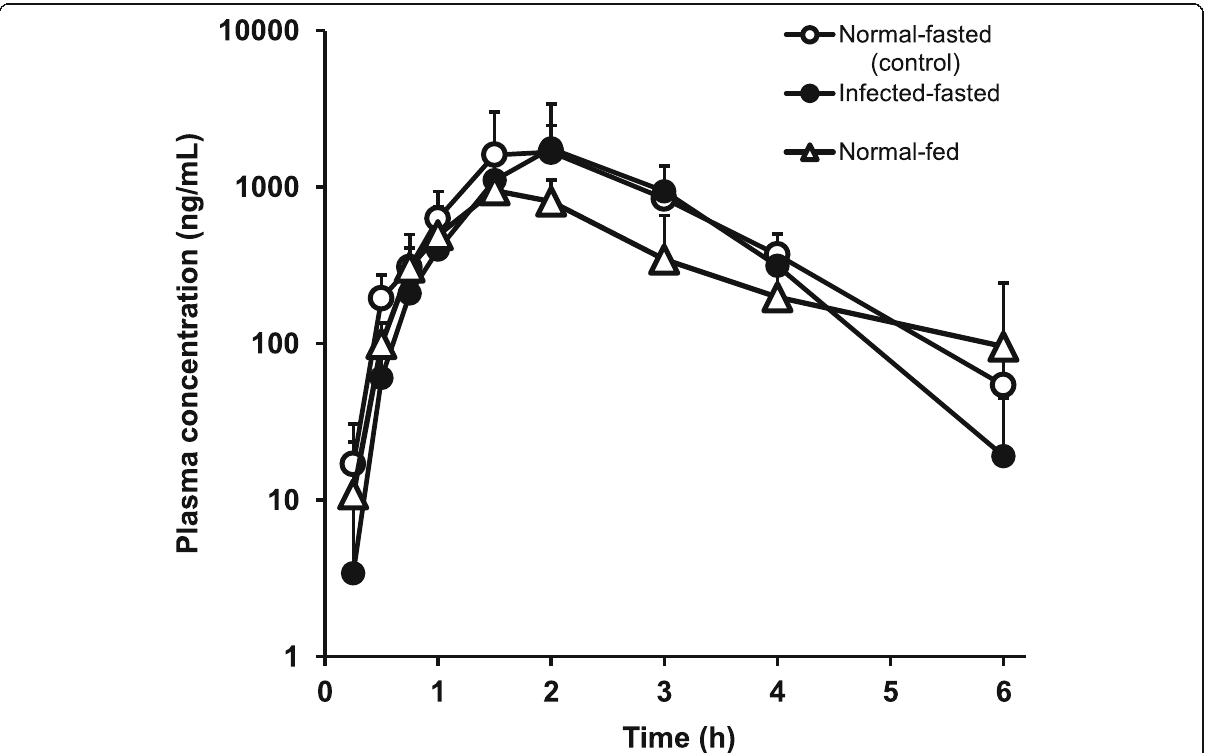
Fig. 3 Effects of food and parasite infection on the absorption behavior of N-251. The dose of N-251 was 68 mg/kg. Results were expressed as mean with the bar showing the SD value